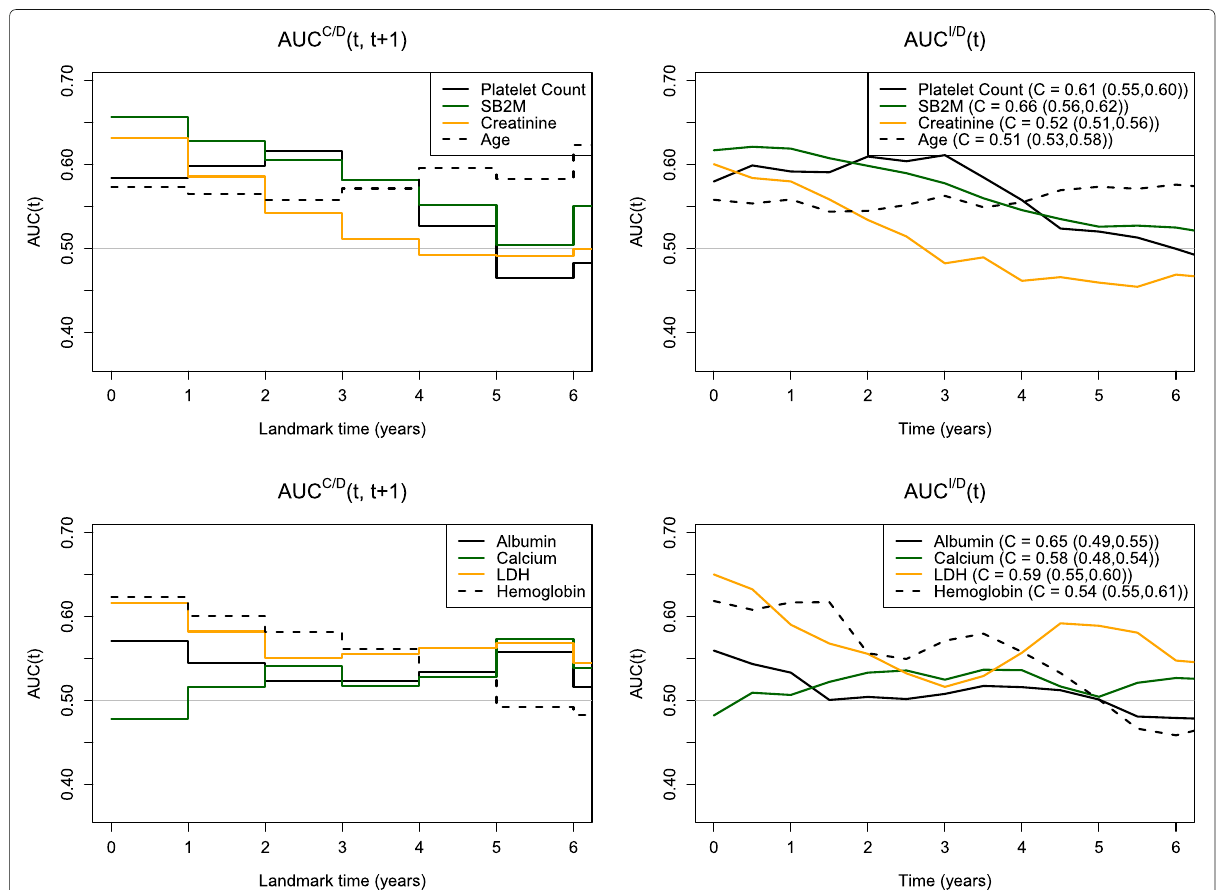
Fig. 4 Marker performance over time using AUC C / D and AUC I / D (along with C-index estimates and corresponding 95% bootstrap confidence intervals). The markers have been split up into two sets displayed in the top panel (platelet count, SB2M, creatinine, and age) and the bottom panel (albumin, calcium, LDH, and hemoglobin) for clarity. This figure appears in color in the electronic version of this article